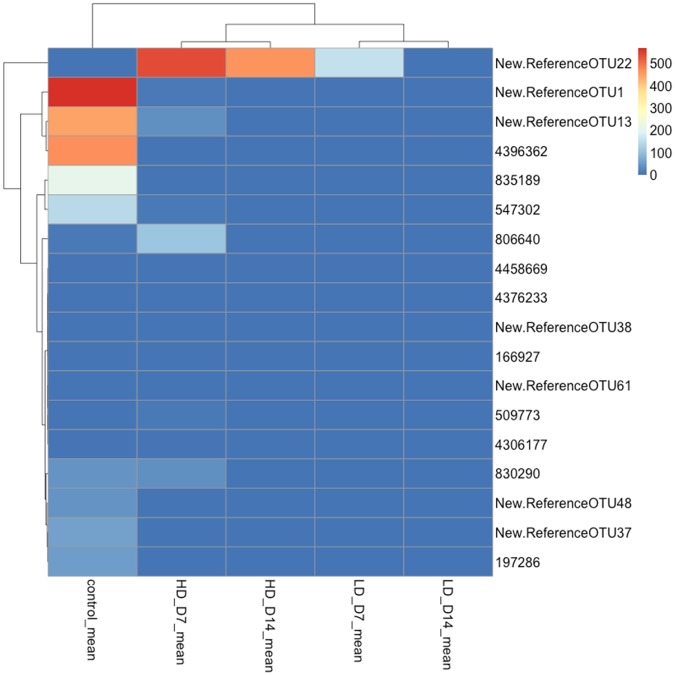
Heat map showing the mean relative abundances of OTUs that were found to be significantly different in control and SAV3 infected experimental groups.The taxonomic classification of each OTU number is shown in Table 2. LD_D7: low-dose infected day 7; LD_D14: low-dose infected day 14; HD_D7: high-dose infected day 7; HD_D14: high-dose infected day 14.